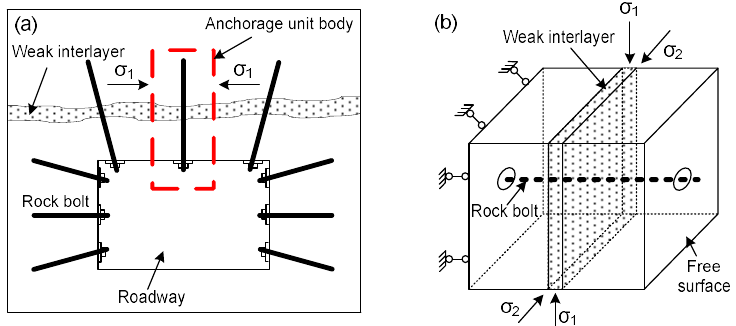
Figure 1. ( a ) Schematic diagram of unit anchorage; ( b ) Test prototype and mechanical model.